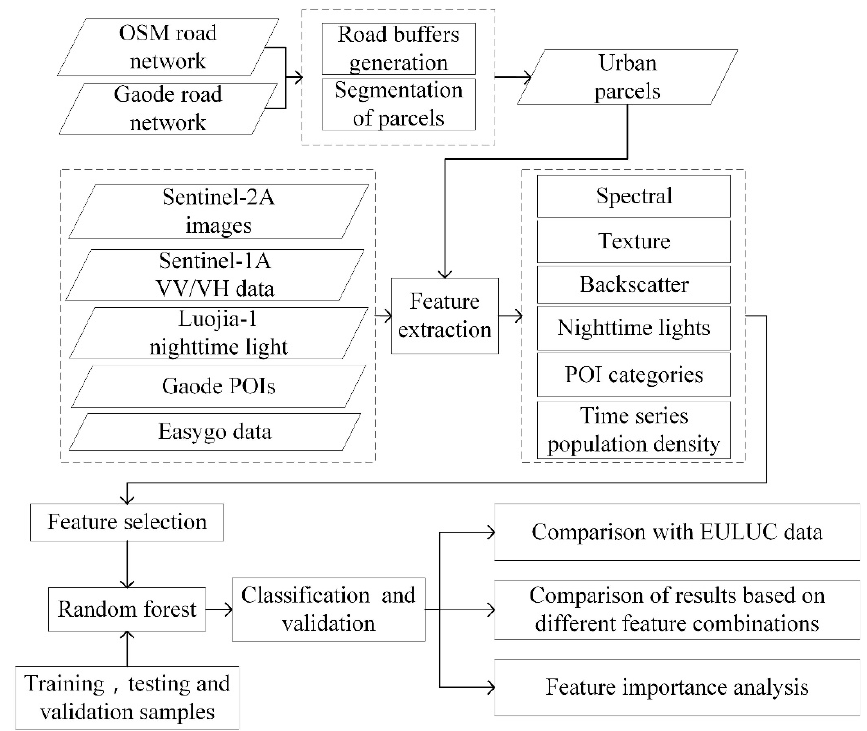
Figure 2. Technique flow chart.